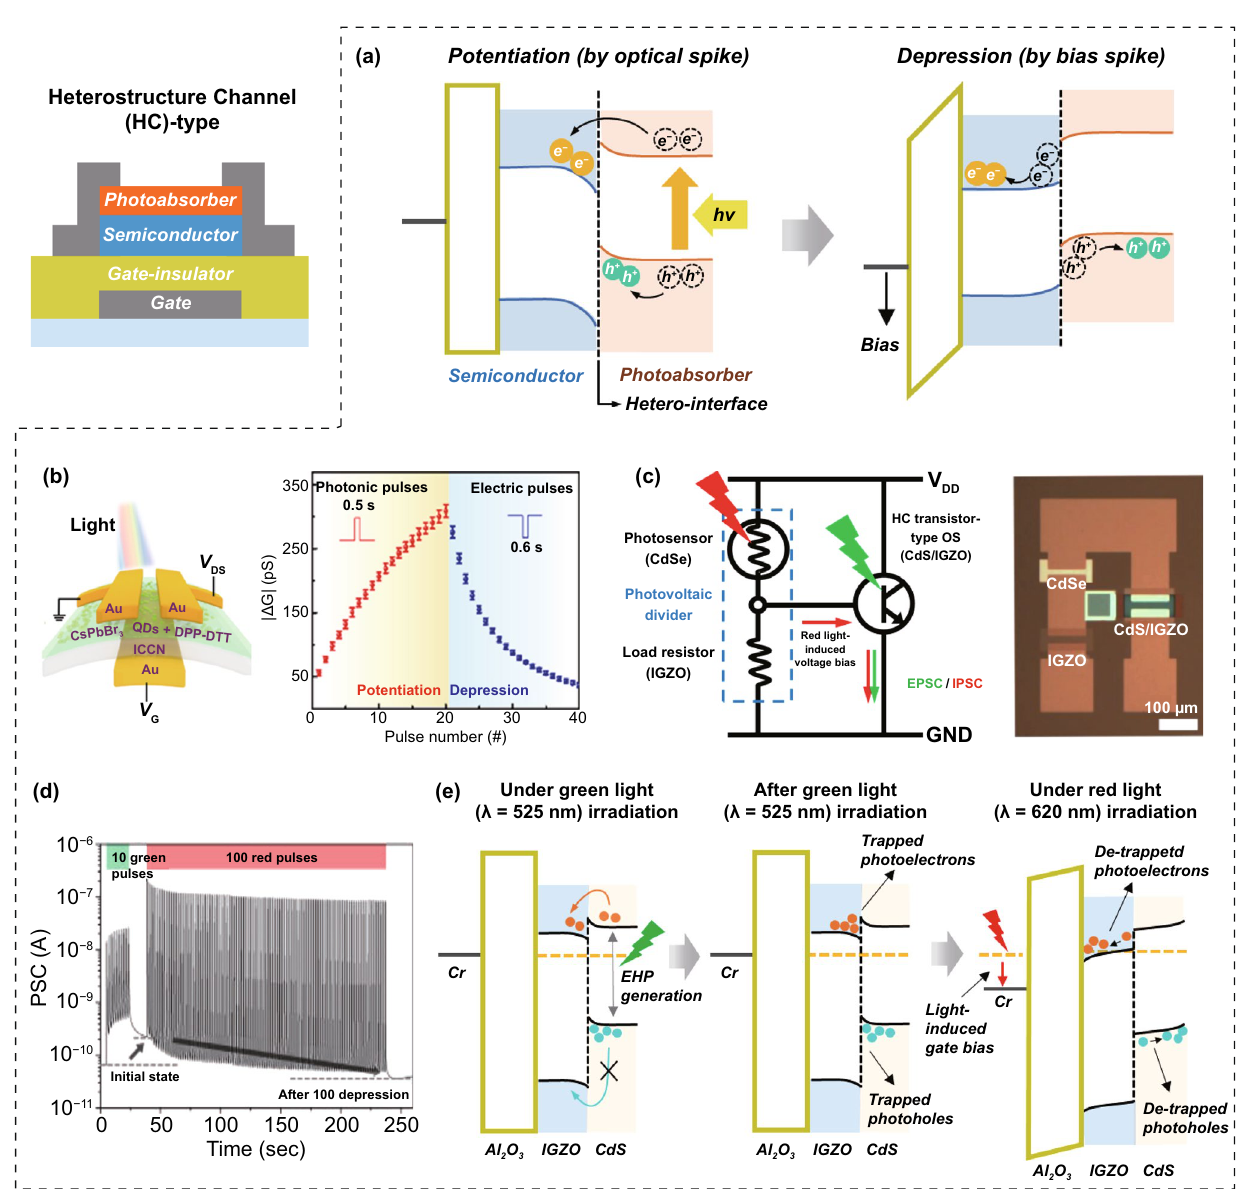
Fig. 8 Heterostructure channel (HC) transistor‑type OS; a operation mechanism, b optical potentiation and electrical depression characteristics. Optoelectronic circuit consisting of photovoltaic divider and HC transistor‑type OS for all‑optical conductance switching function; c circuit schematics, d green light‑induced potentiation and red light‑induced depression of channel conductance, and e operational mechanism. b Repro‑ duced with permission from Ref. [63]. Copyright 2022, Elsevier. c , d Reproduced with permission from Ref. [66]. Copyright @ 2022, Wiley‑